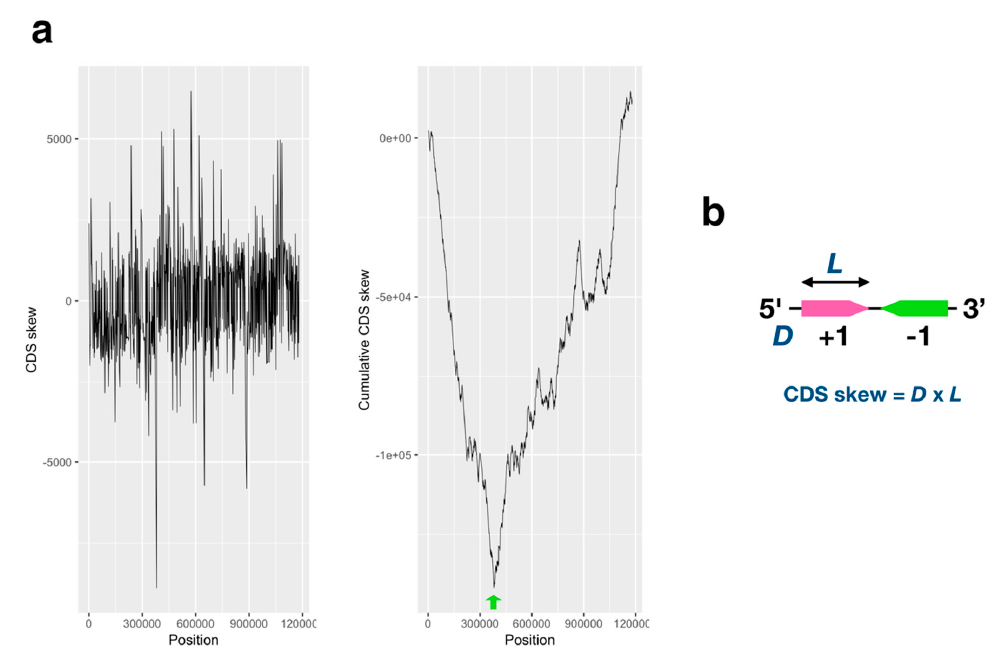
Figure 2. Analyses of the coding sequence (CDS) skew of the APMV genome. ( a ) CDS skew plot (left) and cumulative CDS skew plot (right) of the APMV genome (AY653733.1). The green arrow on the graph on the cumulative CDS skew plot shows the lowest valley point, which was estimated to be genomic region of the origin of 382,698 bp. ( b ) Calculation of the CDS skew index. D: Direction values of the CDS against the APMV genome (AY653733.1); L: CDS length (bp). Pink and green arrows indicate the positive and negative CDS direction on the APMV genome,